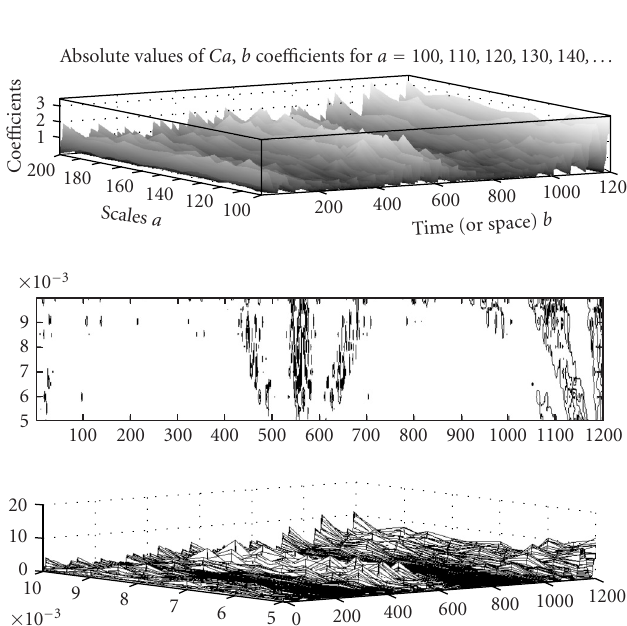
Figure 3.9. Wavelet spectrum with